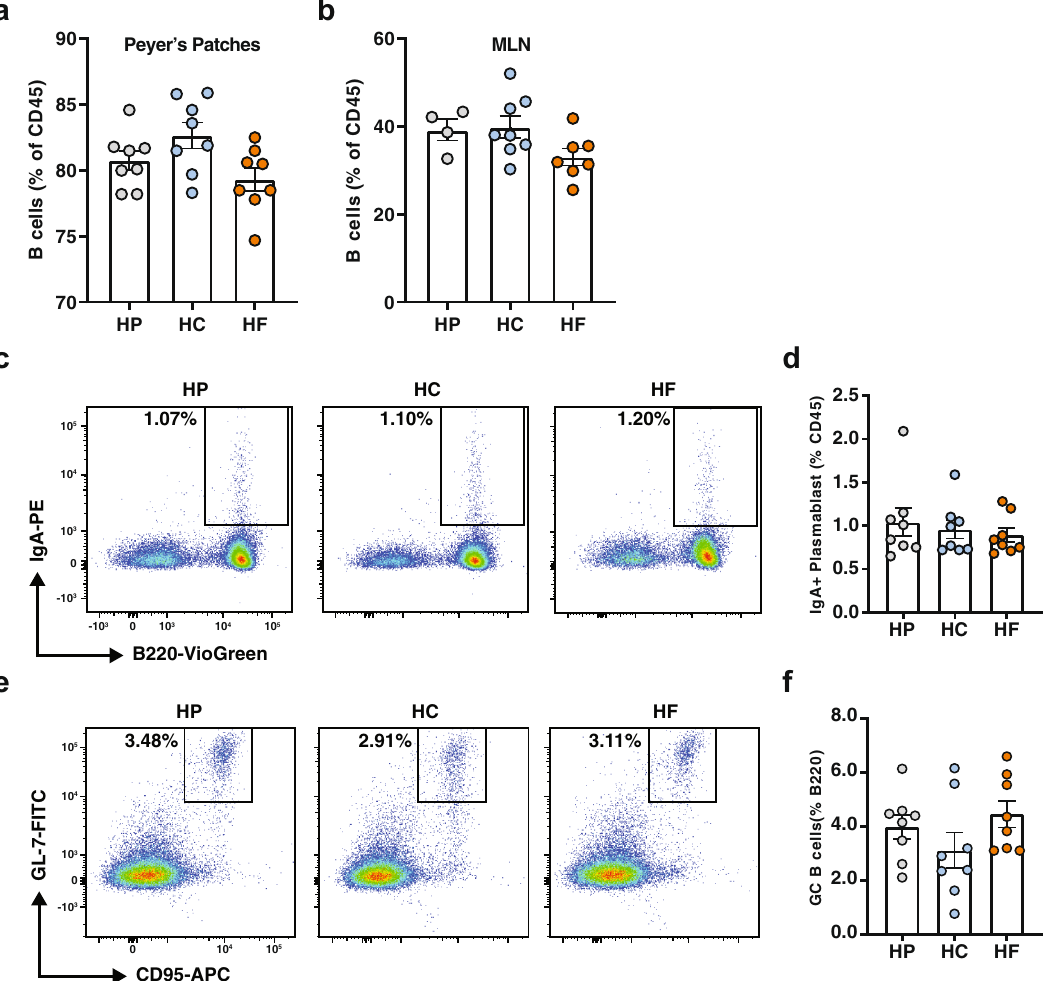
Fig. 2 High protein feeding promotes IgA production through T-cell-independent mechanisms. Mice were fed on either a high-protein (HP), high- carbohydrate (HC) or high-fat (HF) diet for 6 weeks. a Proportion of B220 + B cells in the Peyer ’ s patches ( n = 8 mice per diet) and in the ( b ) mesenteric lymph nodes (MLN; n = 4, n = 8, and n = 7 mice per diet for HP, HC and diet, respectively) were determined by fl ow cytometry. c Representative fl ow cytometry plots representing the proportion of B220 + IgA + plasmablasts in the Peyer ’ s patches and ( d ) corresponding scatter bar graph ( n = 8 mice per diet). e Representative fl ow cytometry plots and graph representing the proportions of CD95 + GL7 + germinal centre B cells in the Peyer ’ s patches and ( f ) corresponding scatter bar graph ( n = 8 mice per diet). Data are represented as mean ± SEM. Results represent n = 2 independent